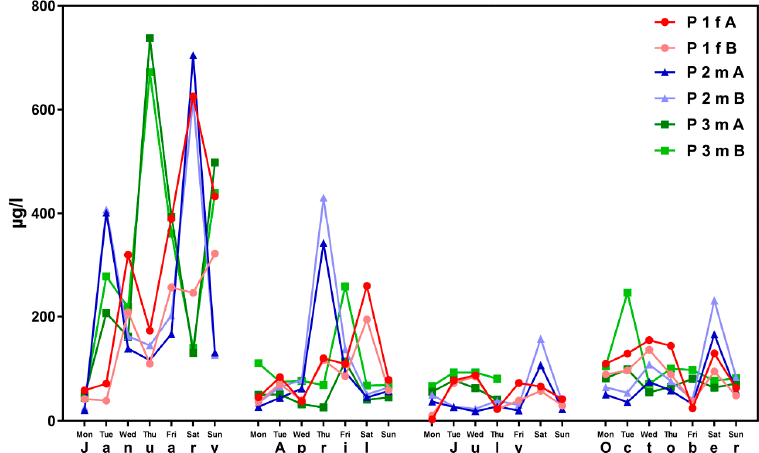
Figure 1. Variability in urinary concentrations of ∑ 5OH-MEHP + 5oxo-MEHP (A) and 5cx-MEPP (B) in morning urine of one female (f) and two male (m) subjects at the age between 15 and 30 years (general population) over four periods of seven days each (one per season of the year). The number starting with “P” is the subject identifier.